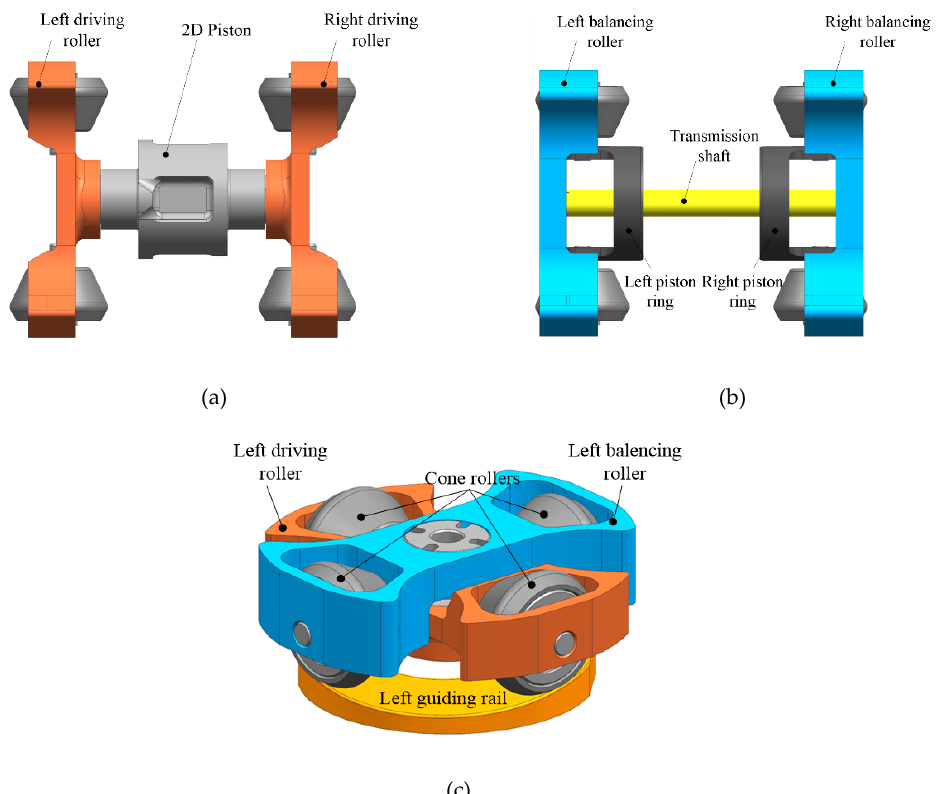
Figure 3. Critical structures of the high-speed 2D piston pump [17]. ( a ) Driving set; ( b ) balancing set; ( c ) left roller set.